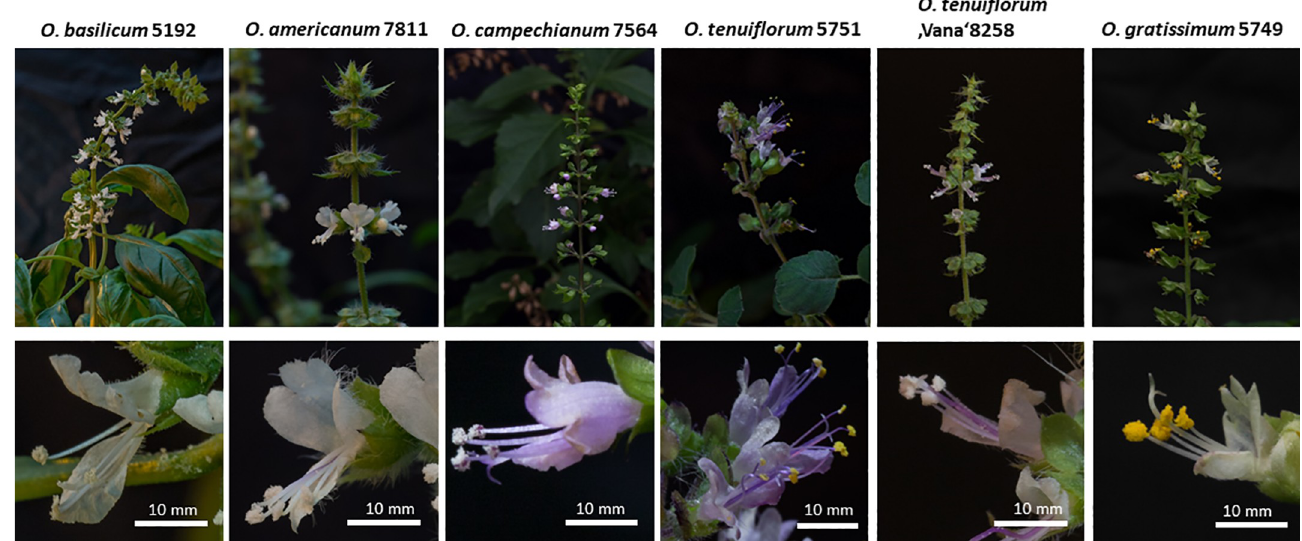
Fig 1. Representative specimens of Ocimum accessions used in the current study in the flowering stage. The upper row shows the inflorescence, the lower row shows close-ups of individual flowers with details of morphology. Size bar 10 mm.